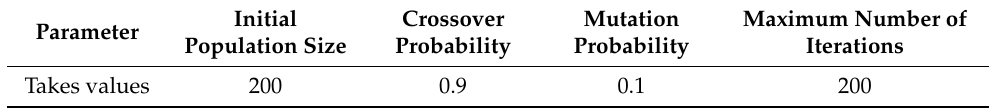
Table 8. Genetic algorithm parameter setting.